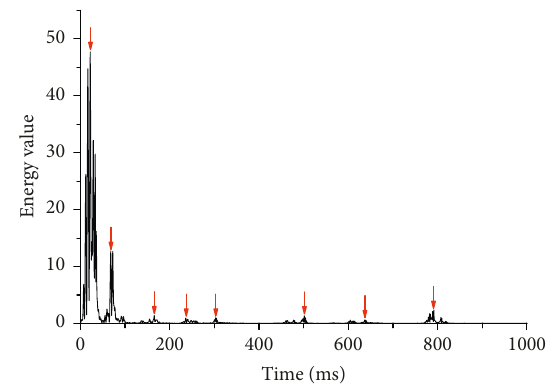
Figure 18: The time-energy distribution of the blasting before optimization.